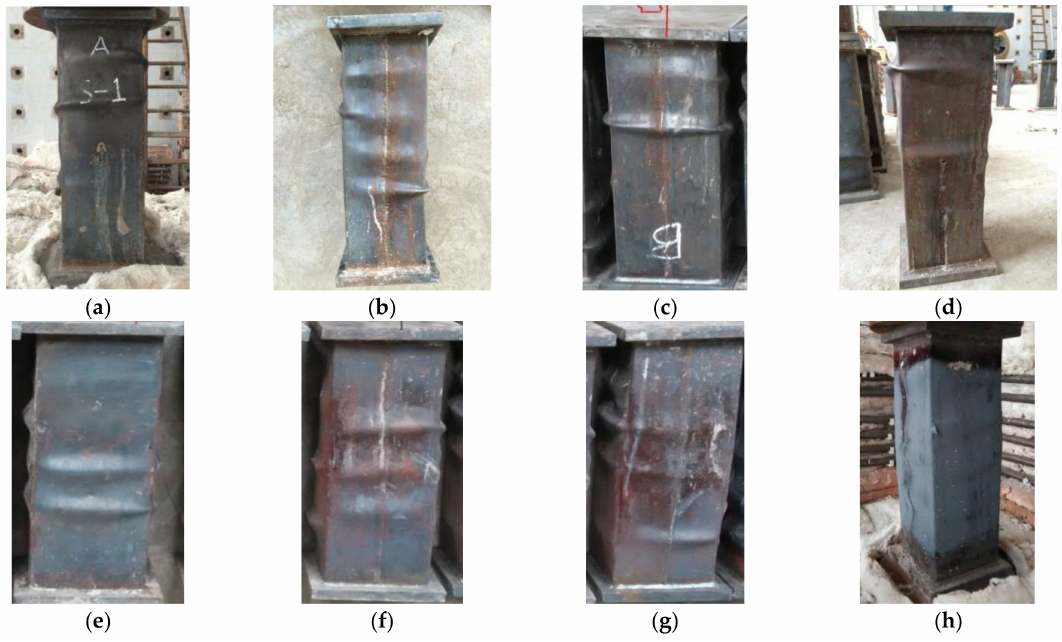
Figure 4. View of specimens after test ( a ) DS-20; ( b ) DS-100; ( c ) DS-200; ( d ) DS-200-0; ( e ) DS-400; ( f ) DS-600; ( g ) DS-600-0; ( h )